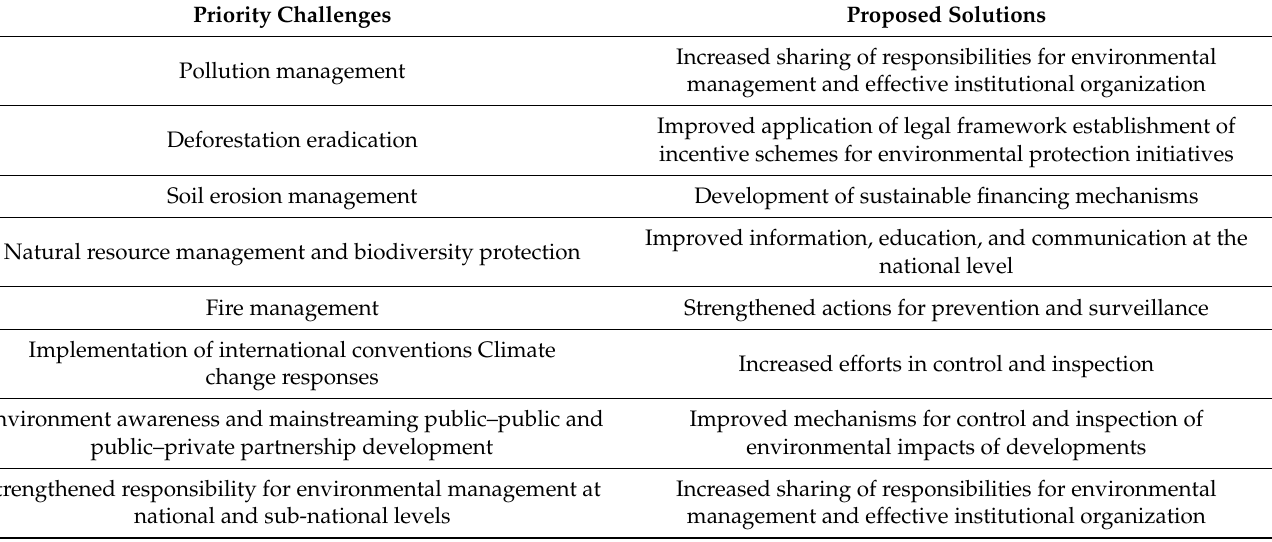
Table 5. Madagascar environment’s priority challenges and proposed